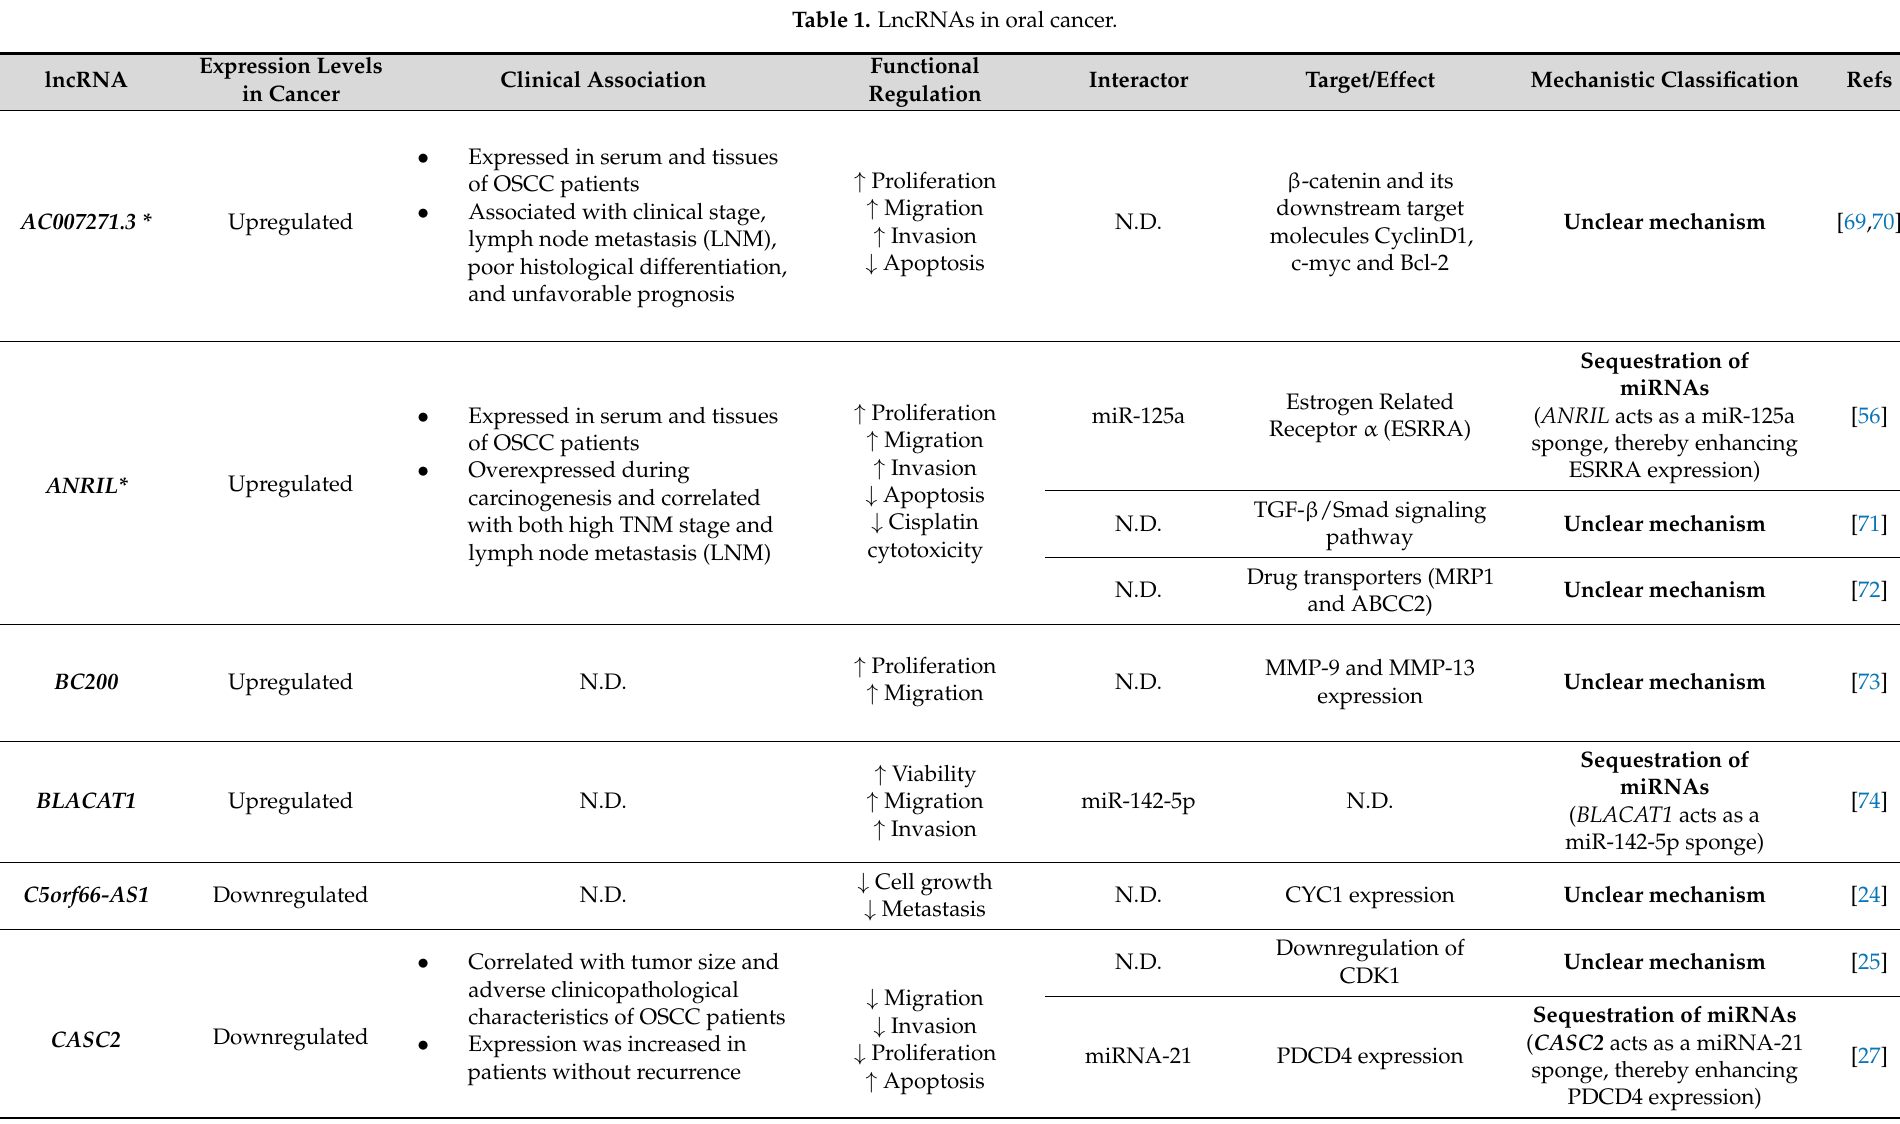
Table 1. LncRNAs in oral